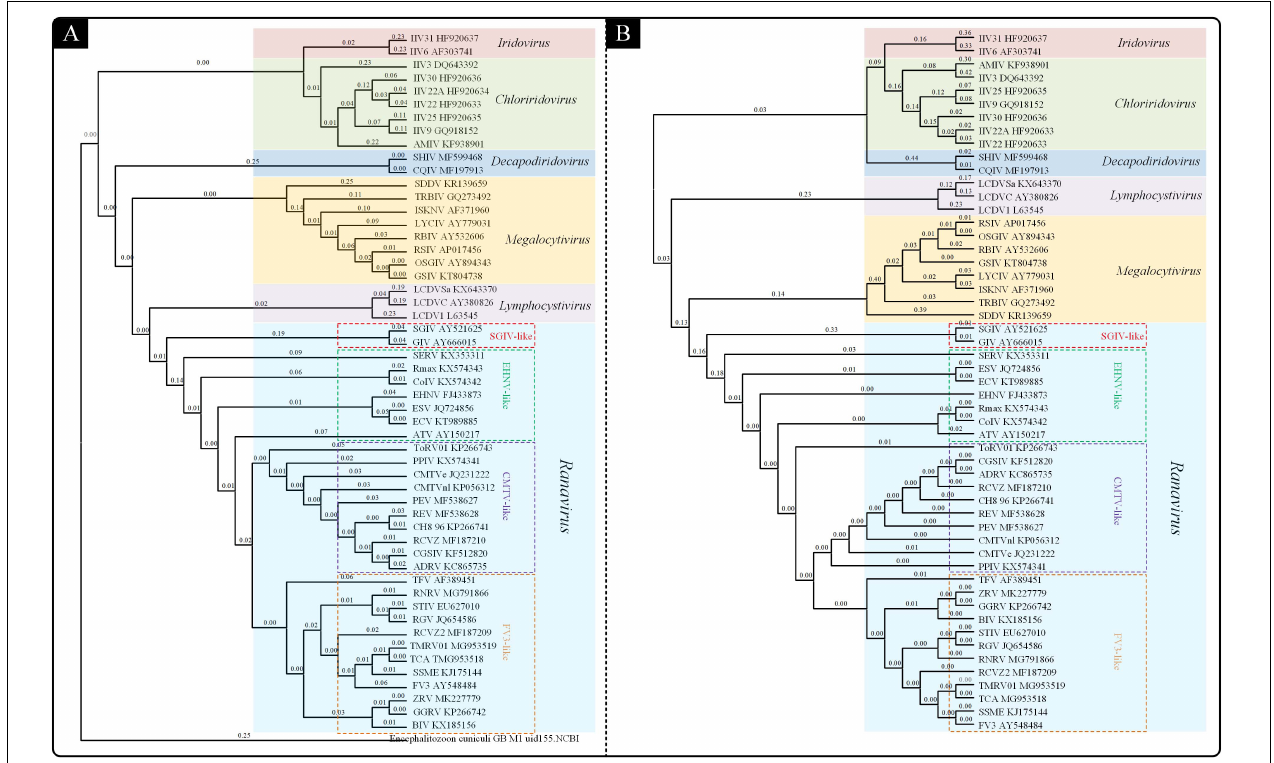
FIGURE 1 | Phylogenetic analysis of the Iridoviridae family. (A) Phylogenetic tree based on genomic amino acid sequences constructed using composition vector method (CV-Tree). (B) Phylogenetic tree based on the 23 Iridoviridae core genes constructed using maximum likelihood method